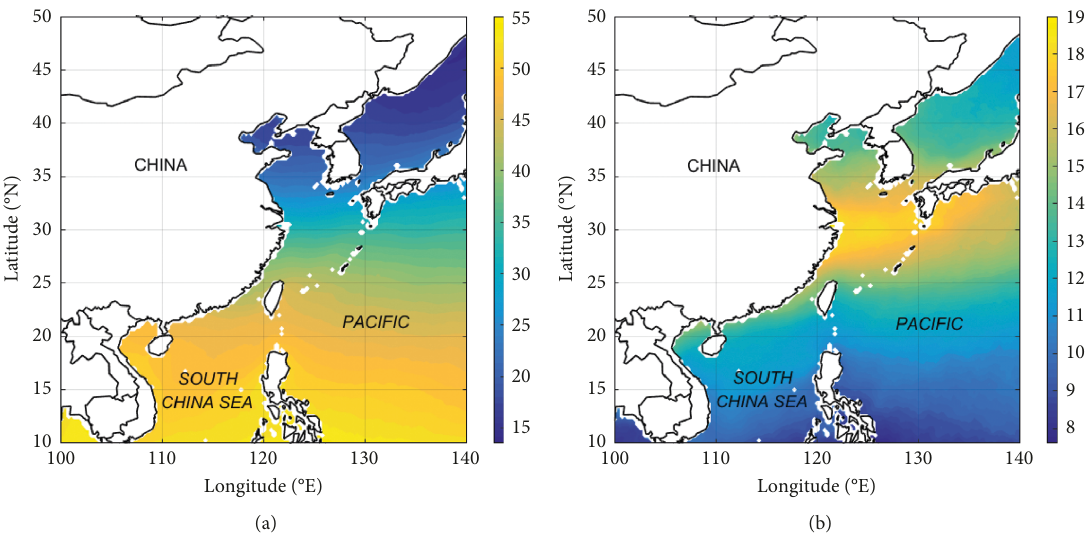
Figure 6: (a) Means and (b) STDs of the PWV derived from the GMI 3-day composites for the period of 2014–2017.